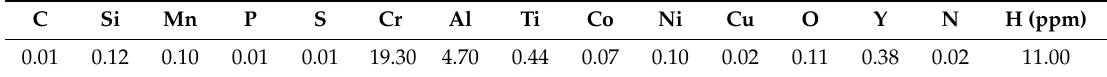
Table 1. Chemical composition of MA956 alloy (wt.